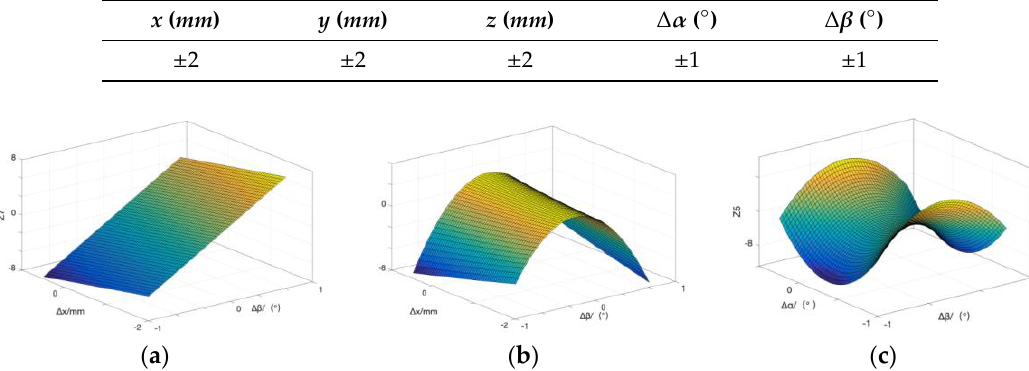
Figure 7. Optical path of the telescope. Table 5. Secondary mirror misalignment range.